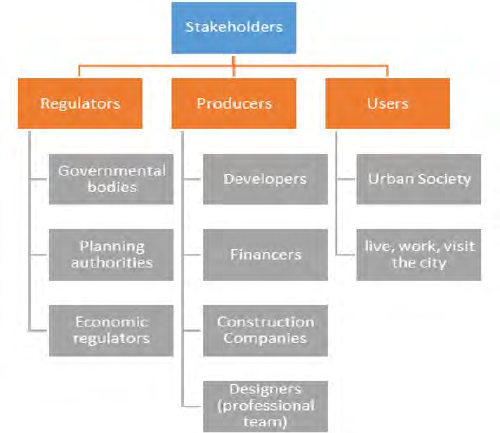
Figure 1. Stakeholders according to type (Madanipour,